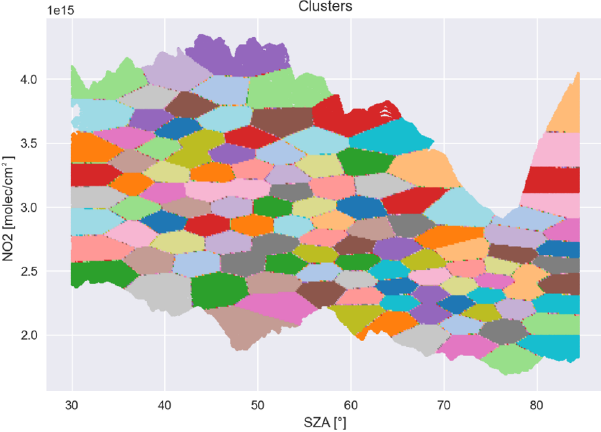
Figure A1. Visualization of decision boundaries used to sort measurements into